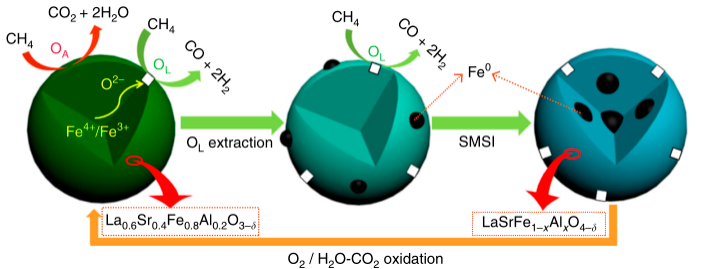
Figure 11. Proposed structural evolution of La 0.6 Sr 0.4 Fe 0.8 Al 0.2 O 3 − δ OC during chemical looping partial oxidation of methane. White boxes represent the coordination unsaturated Fe cations. Reprinted with permission from Ref. [121] , copyright 2018, Nature.